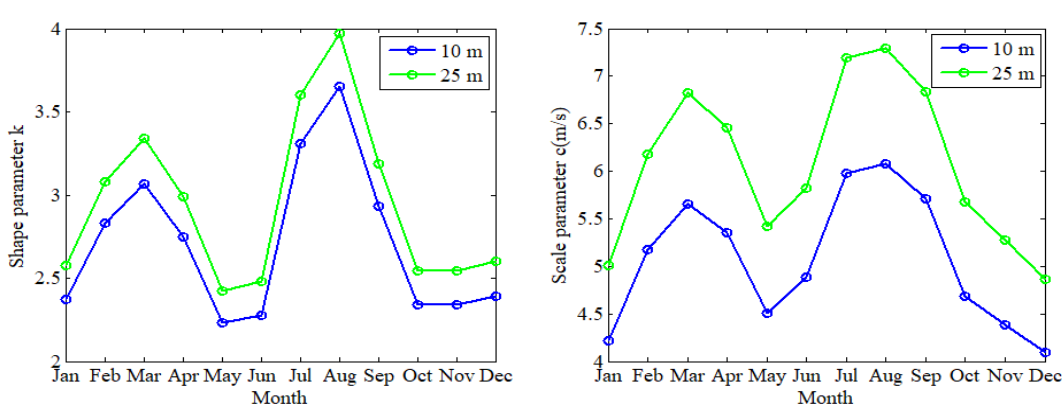
Figure 3. Monthly variation of Weibull parameters at 10 m from the ground (1981-2014) We note that both Weibull parameters show seasonal variation. The shape parameter k varies from 2.23 (May) to 3.65 (August) at 10 m and from 2.3 (May) to 3.98 (August) at 25 m. As for the scale parameter c, it varies from 4.10 m/s (December) to 6.08 m/s (August) at 10 m and 4.75 m/s (December) to 7.30 m/s (August). The highest values of k are observed during the windiest months while the lowest are obtained during the least windy months.